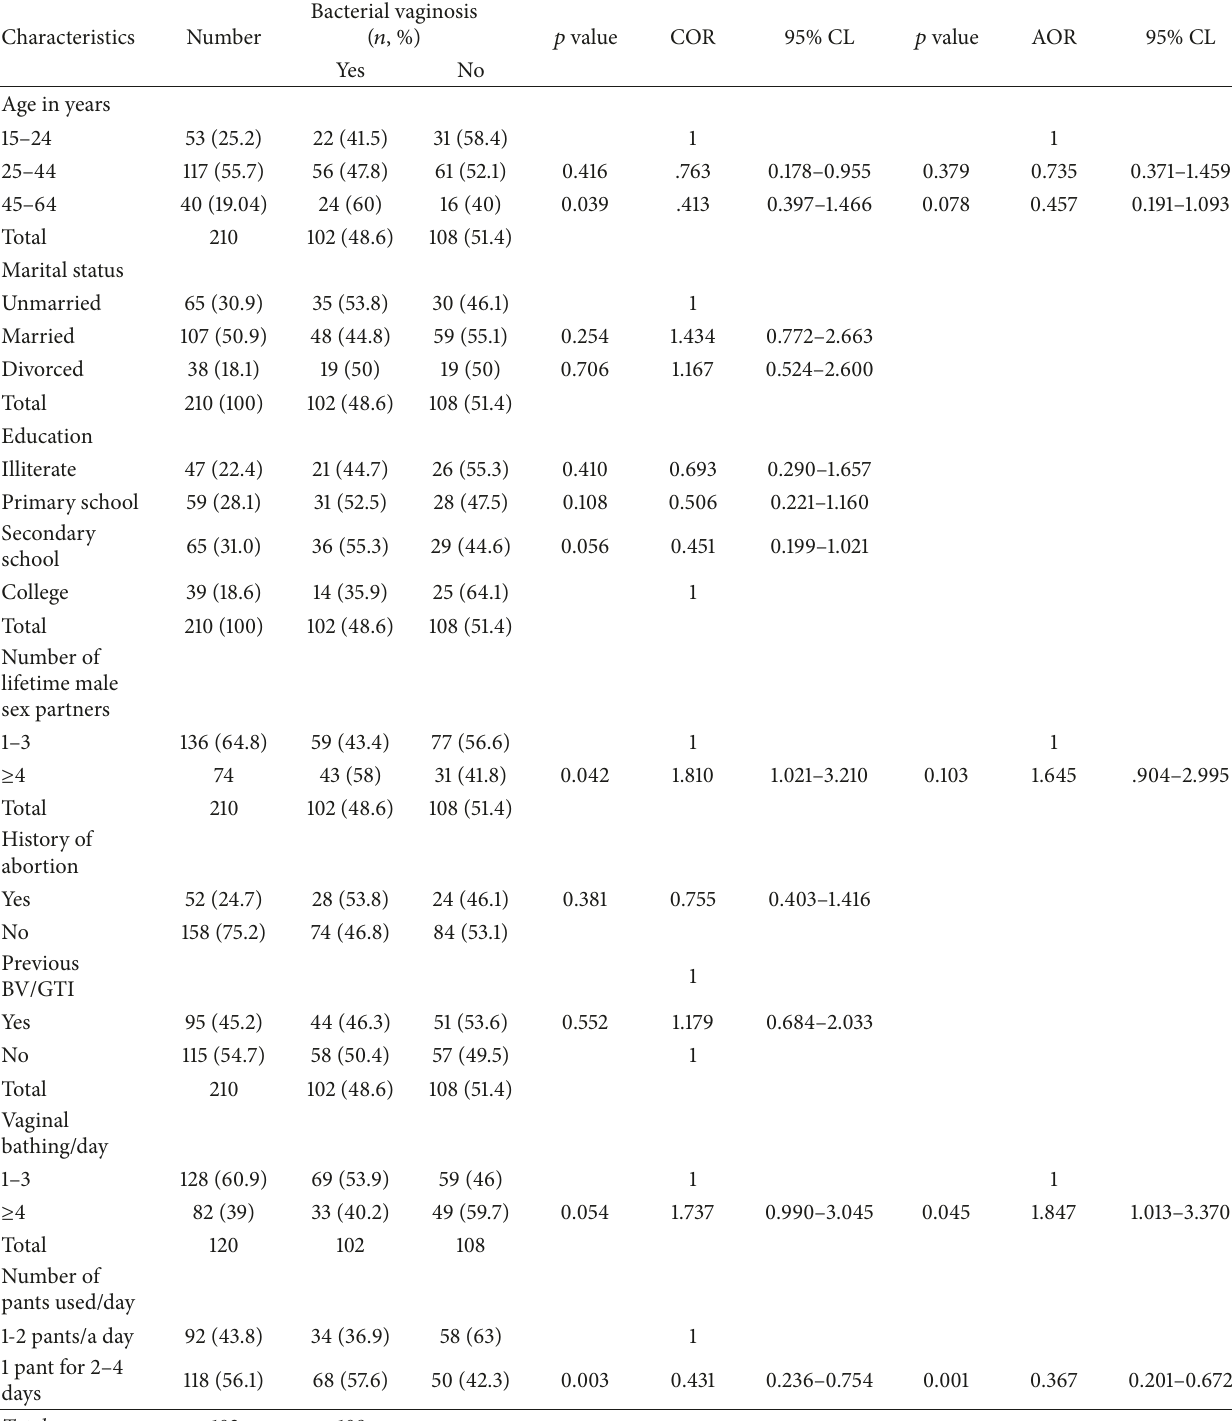
Table 1: Prevalence of bacterial vaginosis (Nugent’s Gram Stain Score: 7–10) by selected characteristics in relation to sociodemographic characteristics, sexual behavior, reproductive health information, and personal hygiene ( 𝑛 = 210